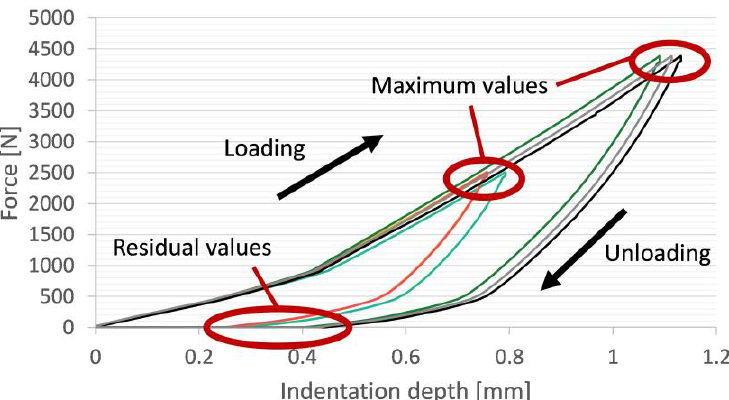
Figure 3. Real loading–unloading curves for one of the reference samples (the different colors mean different measurements on the same sample) .